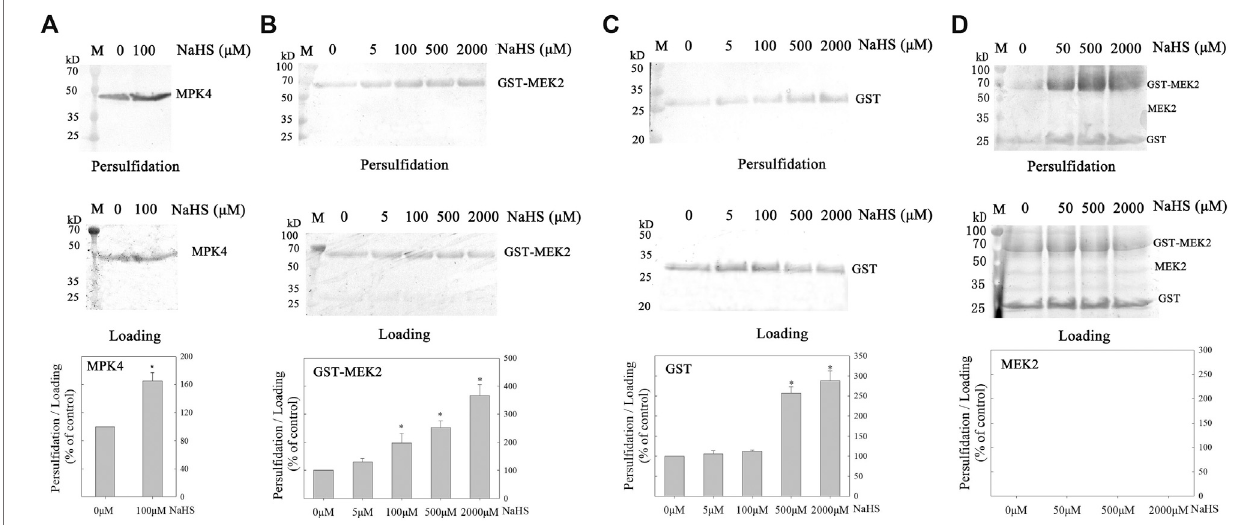
FIGURE 2 | The effect of H 2 S on persul fi dation of MPK4 and MEK2. The effect of H 2 S on persul fi dation of MPK4 (A) , GST-MEK2 (B) , GST (C) and MEK2 (D) . MPK4, GST-MEK2, GST and MEK2 were incubated with NaHS of different concentration as indicated in the Figure in 4 ° C for 30 min, and subjected to biotin-switch assay, in which 10% SDS-PAGE gel and biotin antibody were used. Quanti fi cation anlysis was performed using ImageJ. Data are Mean ± SE, and three independent experiment were repeated. *indicated signi fi cant differences compared with control (Student ’ t -test, p < 0.05). M: